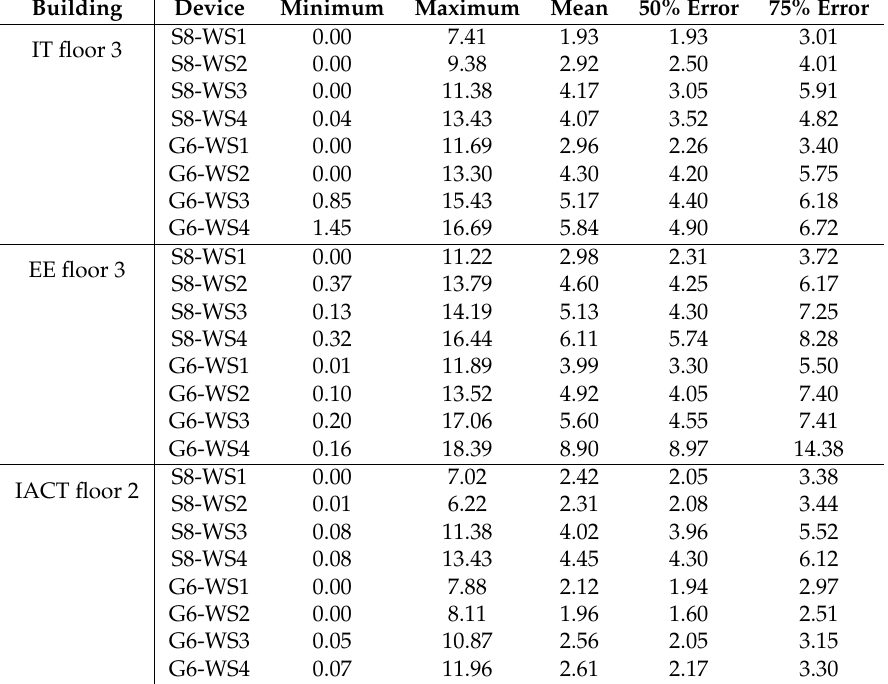
Table 5. The summary of the results with both devices for all